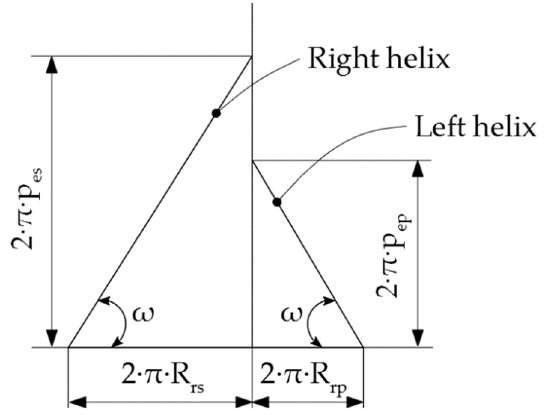
Figure 2. The slope angle of the two helical surfaces.